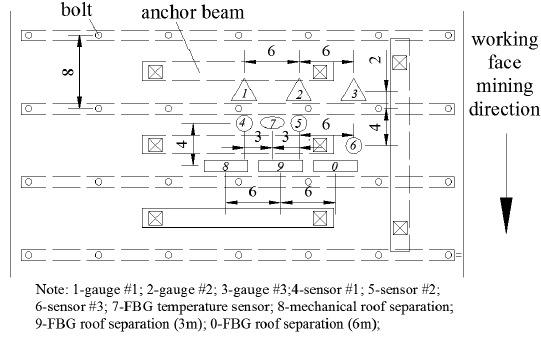
Figure 14. Plan view of FBG sensors layouts in haulage entry roof of 1111(1) working face (unit: Decimeter).